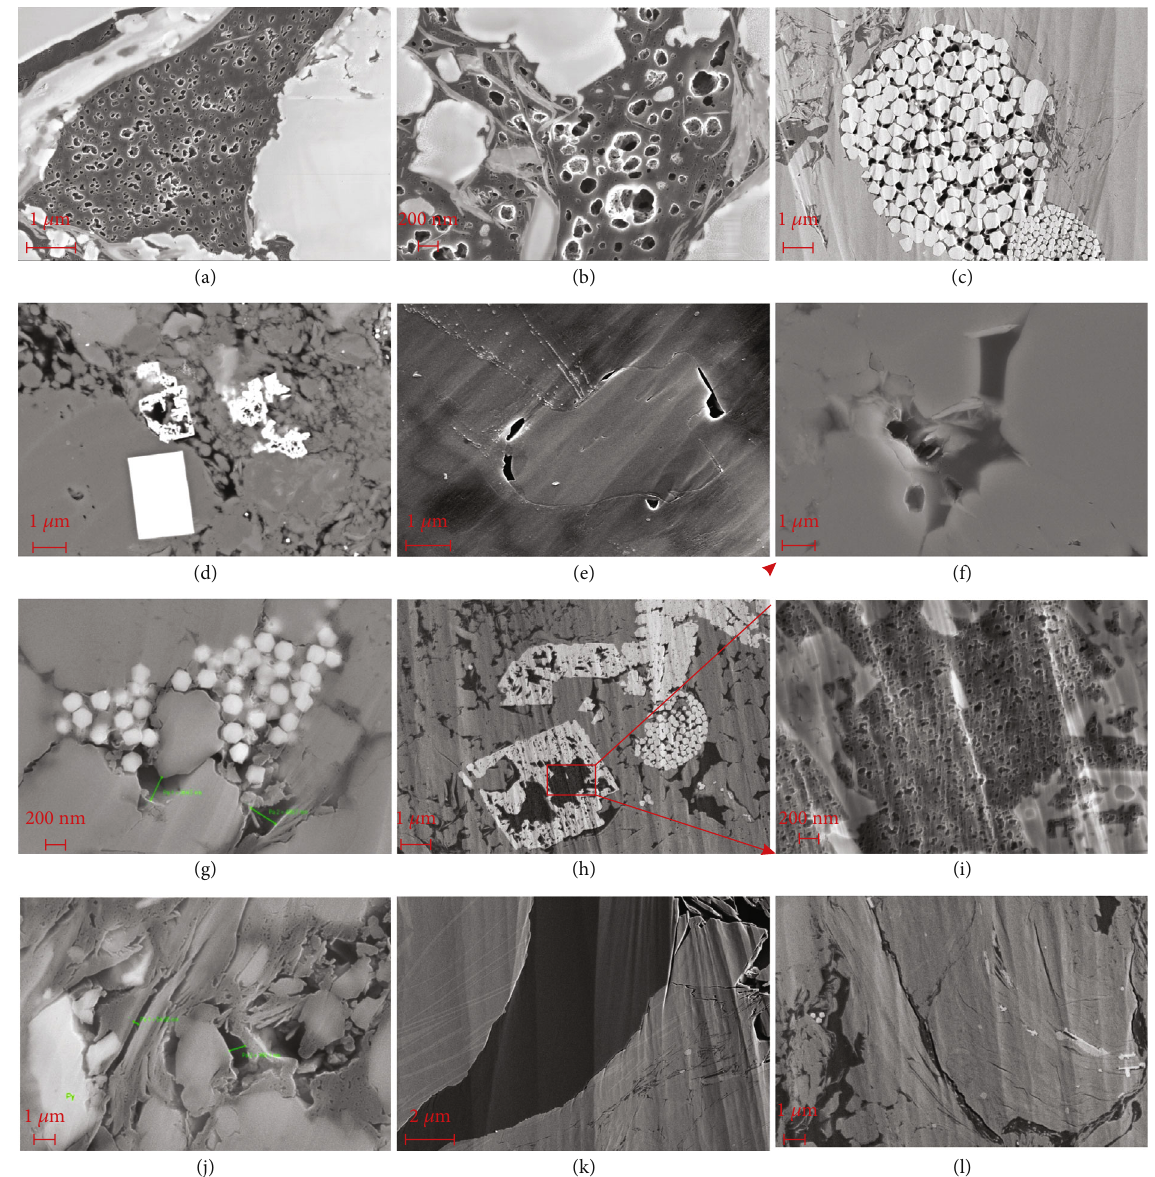
Figure 7: Photos of the FIB-SEM. (a) Well ZY1, 2617.82m, honeycomb-like organic matter pores are densely developed, with good connectivity. The pores are round oval, and the pore diameter is 30-250 nm. (b) Well ZY1, 2618.18m, organic matter pores are extremely developed, the pore diameter is mostly hundreds of nanometers, the pore roundness is high, and there are signs of dissolution at the edge. (c) Well ZY1, 2618.18m, mold ball-shaped intergranular pore, with pore diameter of 10-200 nm. (d) Well ZY1, 2622.01m, intragranular dissolution holes, clay minerals associated with authigenic quartz particles are corroded. (e) Well ZY1, 2622.01m, intergranular pore. (f) Well ZY1, 2612.25m, corrosion hole in clay mineral particles. (g) Well ZY1, 2624.92m, corrosion hole between quartz particles and clay mineral particles, with large pore diameter, greater than 200 nm. (h, i) Well ZY1, 2616.33m, authigenic quartz particles are fi lled with clay minerals and organic matter. After magni fi cation, micropores fi lled with organic matter are developed. (j) Well ZY1, 2614.76m, clay mineral intergranular pores (fractures) and organic matter pores are developed, and corrosion traces can be seen at the edge of authigenic quartz particles. (k) Well ZY1, 2613.00m, massive organic matter pores are underdeveloped, and it can be seen that the contact contraction joint between clay minerals and kerogen is developed. (l) Well ZY1, 2618.70 m, microfractures run through the horizon, partially fi lled with organic matter, and several clay mineral contraction joints are